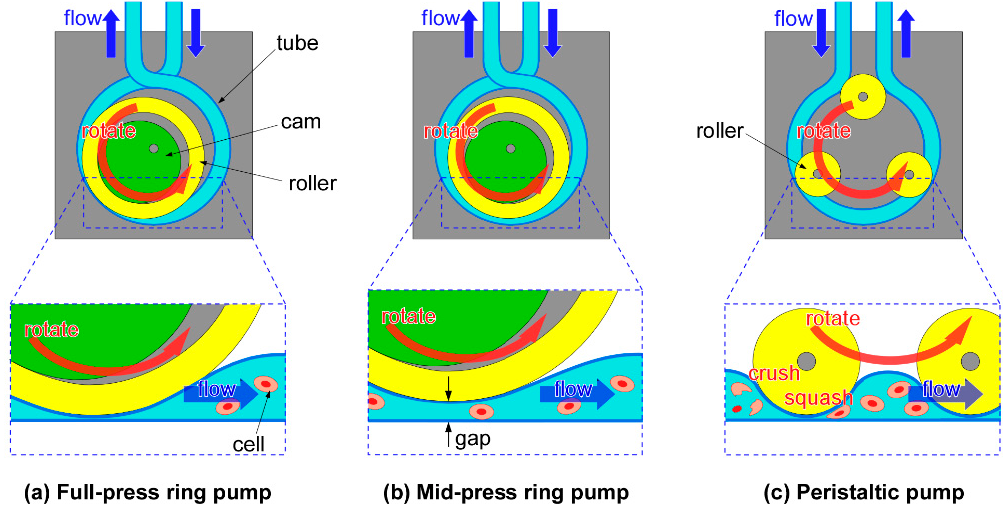
Figure 1. Schematic illustrations of three types of tube pumps. ( a ) The full-ring press pump (FRP) has a large size roller to stroke the tube, and the cells are not easily crushed. ( b ) The mid-press ring pump (MRP) also has a large size roller, but it keeps the gap between the inner wall of the tube. Therefore, the MRP is able to send the cell suspensions through the micro space (the gap). ( c ) The peristaltic pump (PP) has small rollers, and these rollers can easily crush cells.